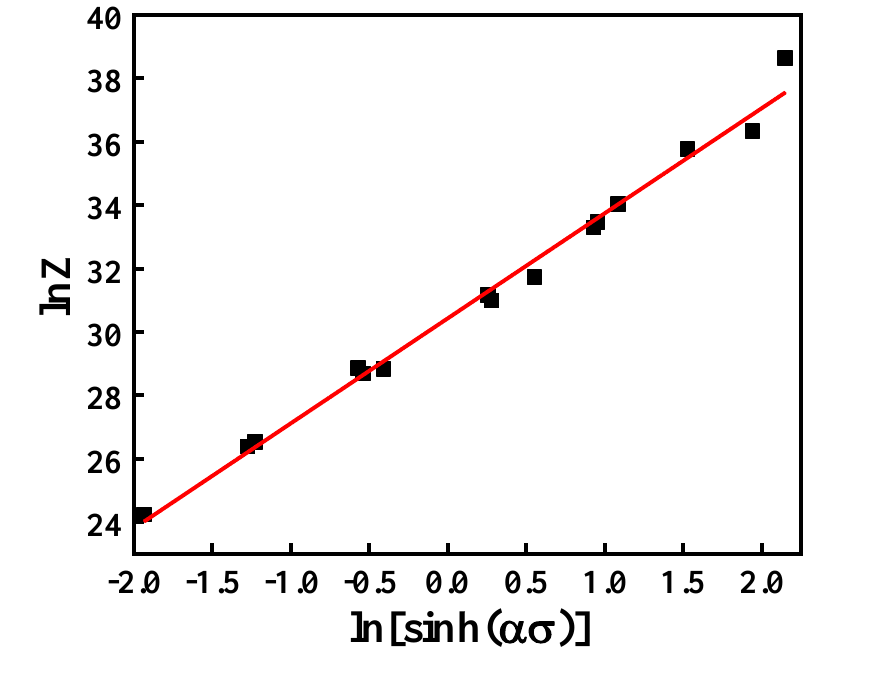
( b ) Figure 5. Relationship between: ( a ) ln𝜀̇ and ln[𝑠𝑖𝑛ℎ(𝛼𝜎)] ; ( b ) ln[𝑠𝑖𝑛ℎ(𝛼𝜎)] and 1/𝑇 . In order to calculate parameter A, the Zener – Hollomon parameter ( 𝑍 ) is utilized, which is expressed as follows: (4) Combining Equations (3) and (4), and taking the logarithm of both sides, Equation (5) is derived. It can be seen that ln𝐴 is the intercept of the line in Figure 6. The value of